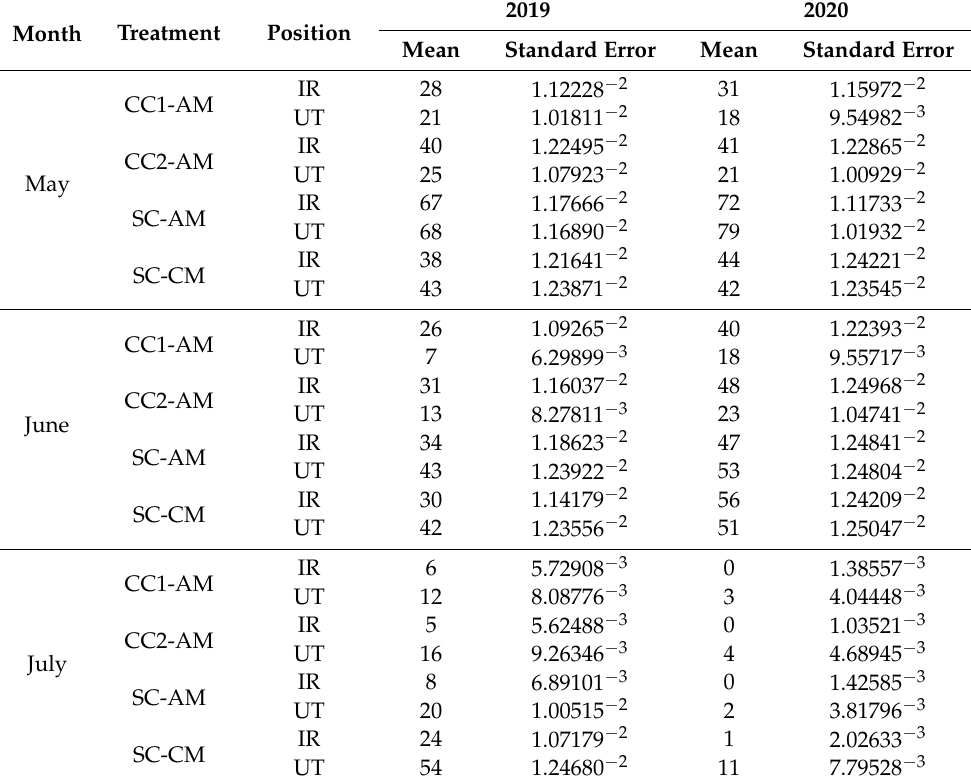
Table A5. Weed cover percentage monthly trend during vines growing season (May–October)